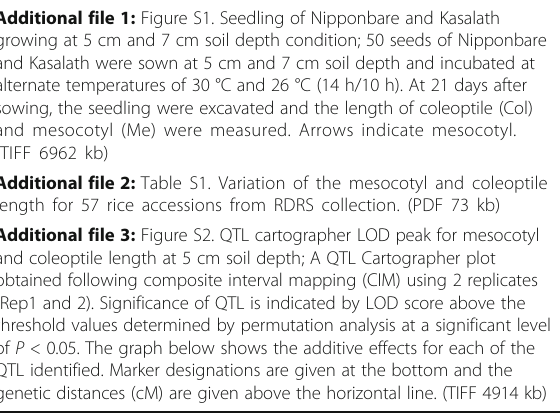
Additional file 1: Figure S1. Seedling of Nipponbare and Kasalath growing at 5 cm and 7 cm soil depth condition; 50 seeds of Nipponbare and Kasalath were sown at 5 cm and 7 cm soil depth and incubated at alternate temperatures of 30 °C and 26 °C (14 h/10 h). At 21 days after sowing, the seedling were excavated and the length of coleoptile (Col) and mesocotyl (Me) were measured. Arrows indicate mesocotyl. Additional file 2: Table S1. Variation of the mesocotyl and coleoptile length for 57 rice accessions from RDRS collection. (PDF 73 kb) Additional file 3: Figure S2. QTL cartographer LOD peak for mesocotyl and coleoptile length at 5 cm soil depth; A QTL Cartographer plot obtained following composite interval mapping (CIM) using 2 replicates (Rep1 and 2). Significance of QTL is indicated by LOD score above